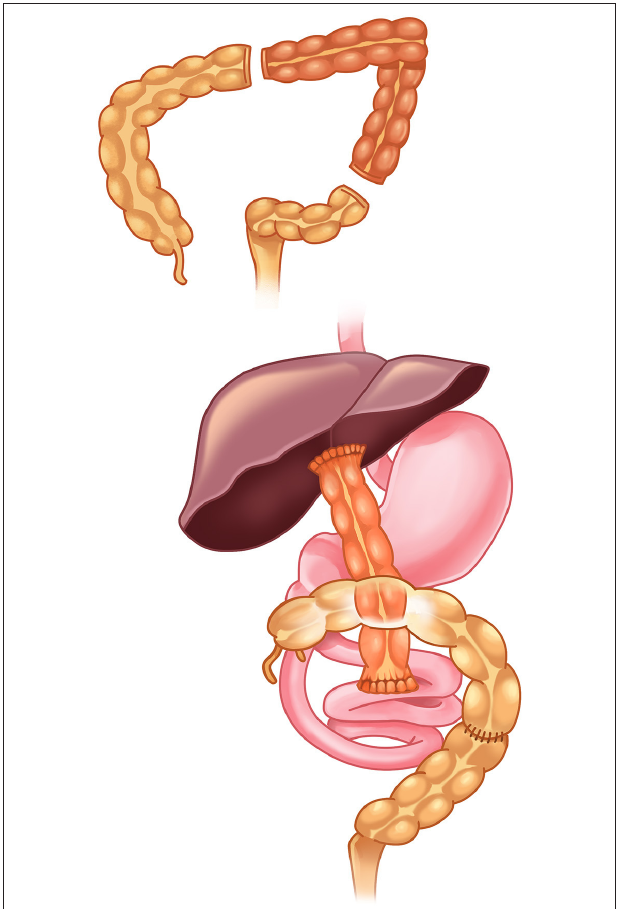
FIGURE 1 | A segment of the colon was used as a biliary conduit. End-to-side colojejunostomy was performed at 10cm from the ligament of